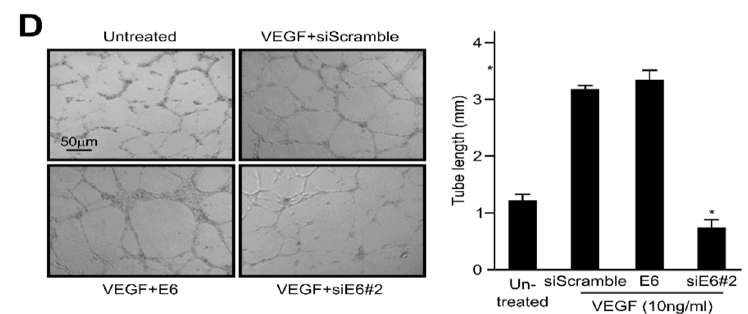
Figure 2. HPV16 E6 facilitates vascular endothelial growth factor (VEGF)-induced endothelial cell migration, proliferation and tubular network formation in vitro. ( A , B ) Boyden chamber-based migration assays were conducted to determine whether the transfected HPV16 E6 regulates the effects of VEGF on endothelial cell migration. After treatment with VEGF, HUVECs were transfected with siScramble, HPV16 E6 or HPV16 E6-siRNA (siE6#2) ( A ), or siE6#2 constructs at various concentrations ( B ). Human umbilical vein endothelial cells (HUVECs) were added to the top chamber of the Boyden Transwell chamber (pore size, 8 μ m), fixed, and then stained with Haematoxylin and Eosin (H&E). The number of migrated cells was evaluated under a light microscope. Three independent experiments were conducted in triplicate; * p < 0.05 compared with siScramble. ( C ) Effects of HPV16 E6 on endothelial cell proliferation. HUVECs were grown and incubated for 3 days with or without VEGF. The c.p.m. of [ 3 H]thymidine was calculated using a liquid scintillation counter. Each data point represents triplicate samples, and the bars indicate the mean ± SD; * p < 0.05 versus siScramble. All experiments were performed at least three times with consistent and similar results. ( D ) HUVECs were transfected with siScramble, HPV16 E6 or HPV16 E6-siRNA (siE6#2) and then grown on growth factor-reduced Matrigel in the presence or absence of 10 ng/mL VEGF. The capillary-like tubular network formation was monitored under an inverted microscope; scale bars represent 50 μ m. The tube lengths were quantified and expressed as mean ± SD; * p < 0.05 versus siScramble. Each data bar represents the mean ± SD of three independent experiments that yielded similar values.